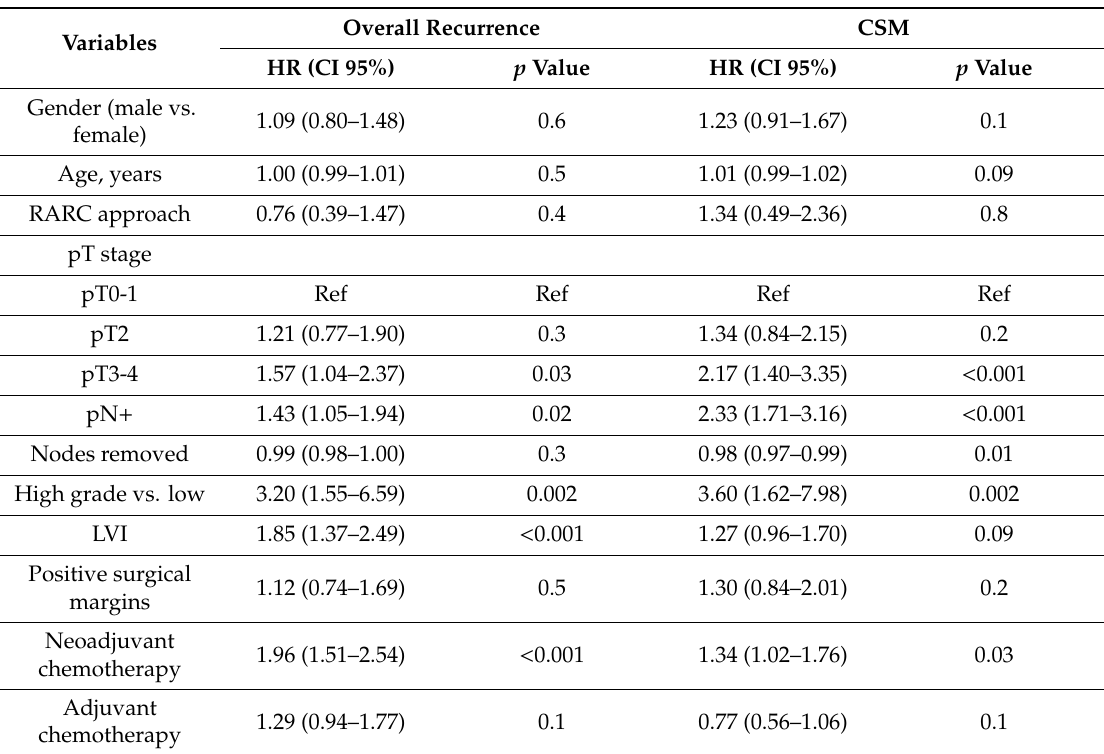
Table 4. Multivariable competing risk analyses predicting the risk of overall recurrence and CSM in patients treated with radical cystectomy after propensity